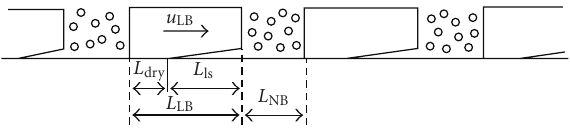
Figure 3: Phase distribution in the near-wall